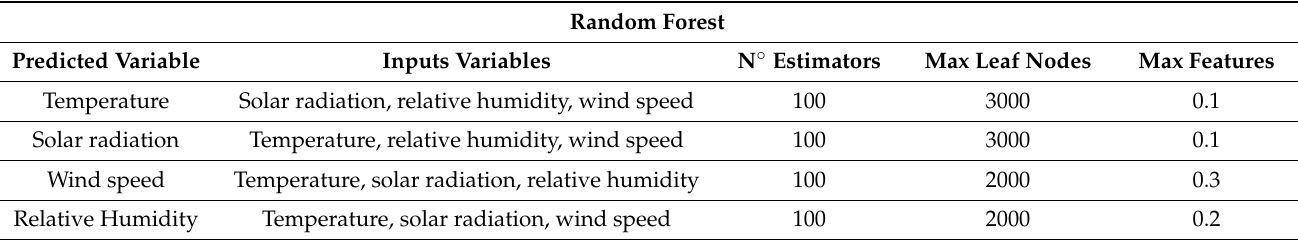
Table 4. Tuning parameters for the random forest